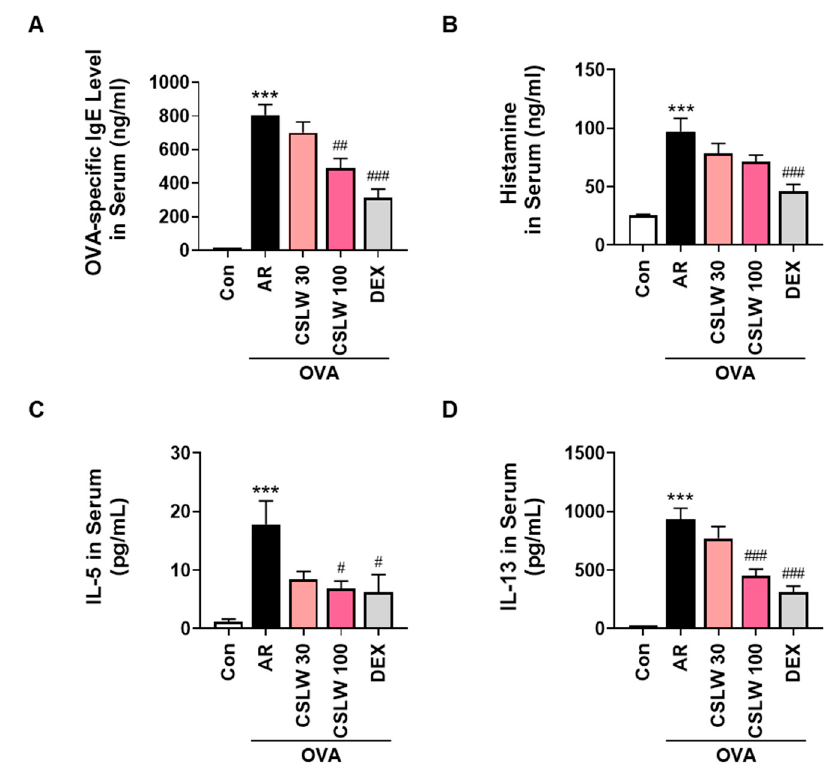
Figure 3. Effect of CSLW on serum levels of inflammatory mediators in an OVA − induced AR mouse model. Serum levels of ovalbumin-specific IgE ( A ), histamine ( B ), IL-5 ( C ), and IL-13 ( D ) were evaluated using ELISA. The values are expressed as the means ± SD ( n = 6 − 7 mice per group). *** p < 0.001 compared with the Con (non − sensitized) group; # p < 0.05, ## p < 0.01, and ### p < 0.001 compared with the AR group. AR, allergic rhinitis; OVA, ovalbumin; CSLW, Caesalpinia sappan Linn. heartwood water extract; DEX, dexamethasone; IL, interleukin.